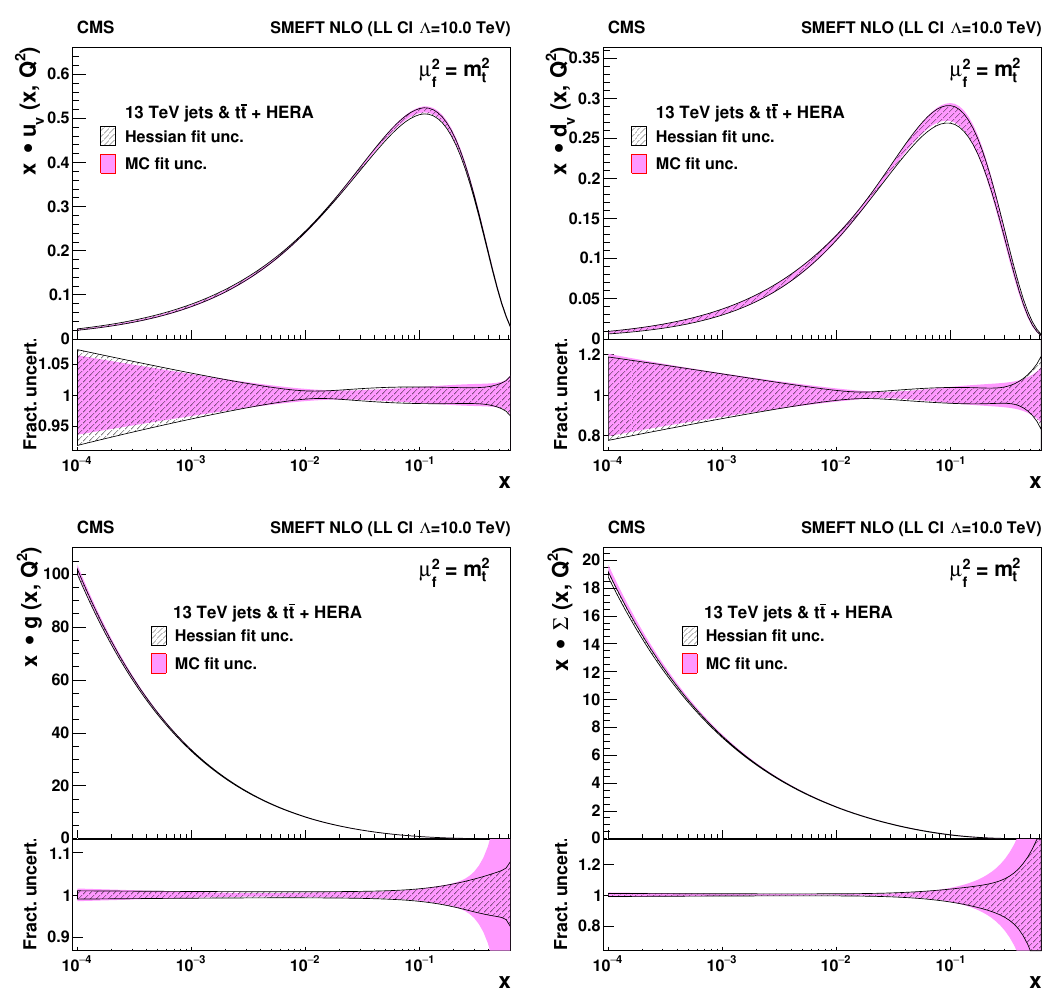
Figure 18 . The u -valence (upper left), d -valence (upper right), gluon (lower left), and sea quark (lower right) distributions, shown as a function of x at the scale µ 2 fit with the left-handed CI model with Λ = 10 TeV. The PDFs are shown with the fit uncertainties obtained by the Hessian (solid blue) and Monte Carlo (solid red)